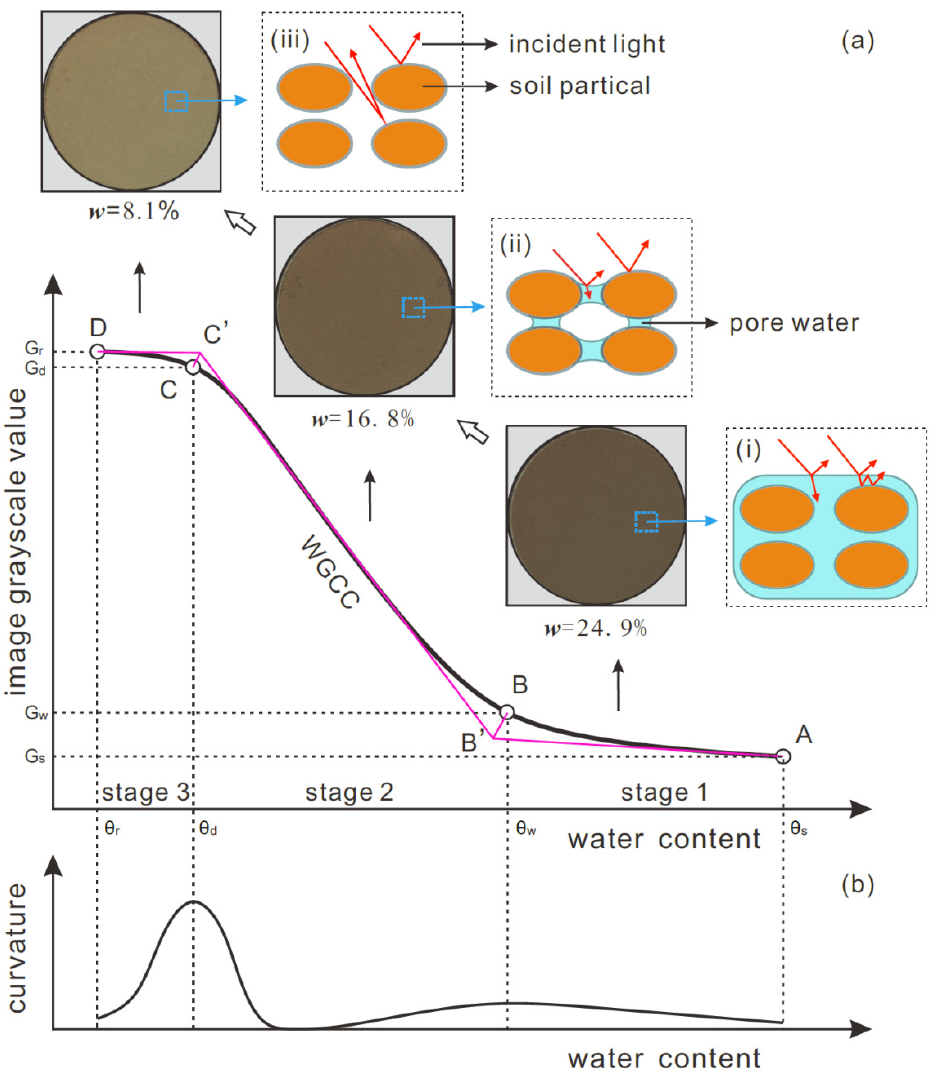
Figure 6. Typical WGCC: ( a ) graphic method to derive inflection points and intrinsic correlation of WGCC stage transition with soil water type; ( b ) WGCC curvature and the analytical method for determining inflection points; (i), (ii) and (iii) are light reflection and refraction in stage 1, 2 and 3, 2 and 3, respectively.